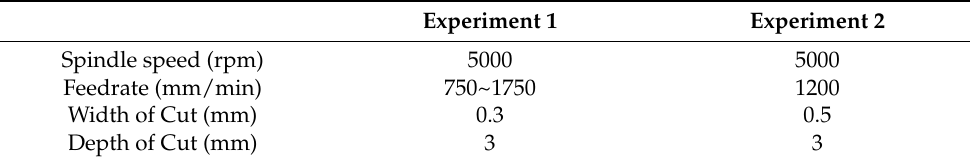
Table 4. Cutting parameters for experiments 1 and 2.